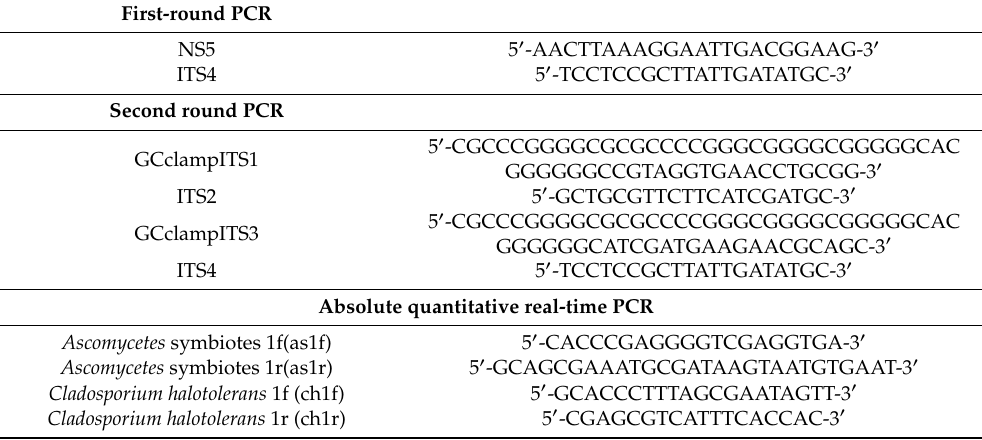
Table 1. Primers and probes used in the polymerase chain reaction (PCR), nested PCR, denaturing gradient gel electrophoresis (DGGE), and quantitative PCR analyses.